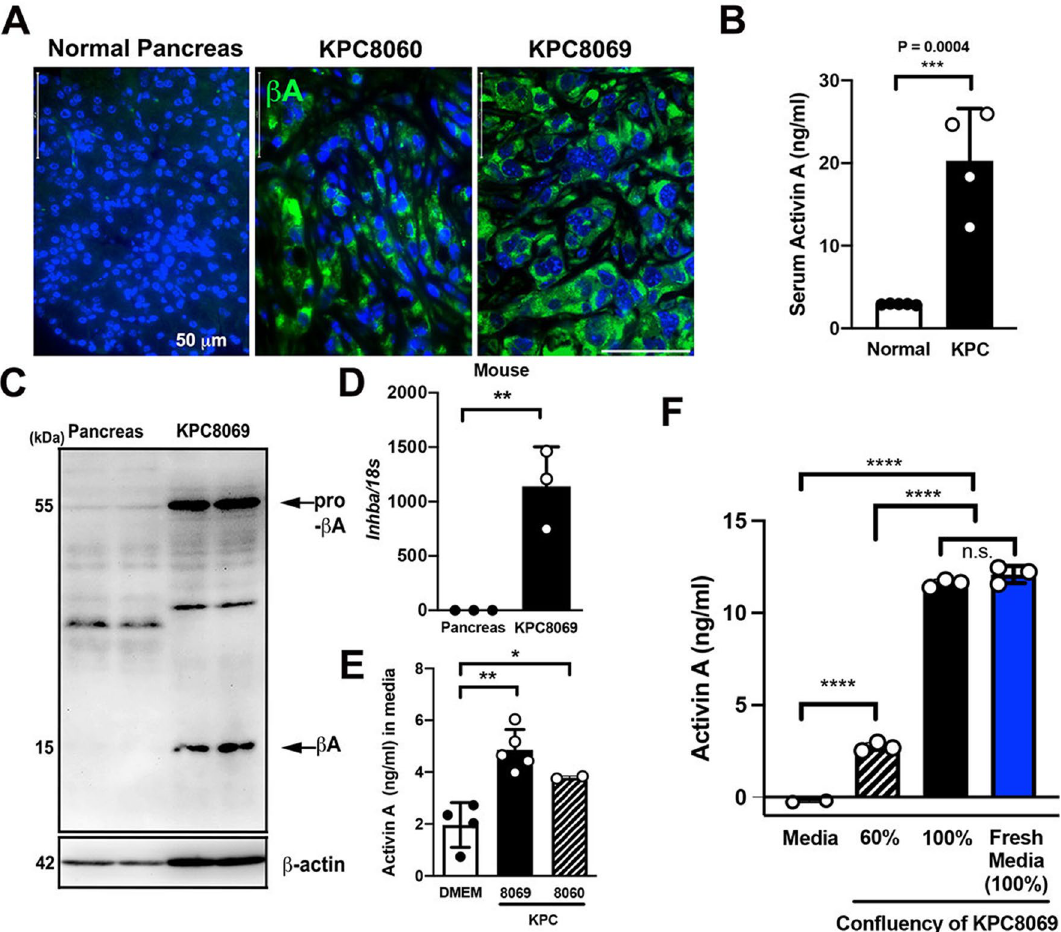
Figure 4. Activin A is highly expressed in tumor specimens and tumor-derived cell lines of genetically engineered mouse models of PDAC. ( A ) Immunofluorescence images of activin A (AF488) in normal mouse pancreas tissue and tumor specimens of KPC 8060 and KPC 8069 mice. Scale bar = 50 µm. ( B ) Measurement of serum activin A levels in healthy control C567BL/6 J and KPC mice. ( C ) Immunoblotting analysis of activin A expression in healthy control C57BL/6 J mouse pancreas tissue and KPC8069 cell lysates. ( D ) Relative Inhba mRNA expression levels in healthy control C57BL/6 J mouse pancreas tissue and KPC8069 cells. ( E ) Measurement of activin A concentration in CM from KPC8060 and KCP8069 cells along with RPMI-1640. ( F ) Measurement of activin A concentration in CM from KPC8069 cells at 60% confluency, 100% confluency and 100% confluency following reintroduction (a blue bar) of fresh culture